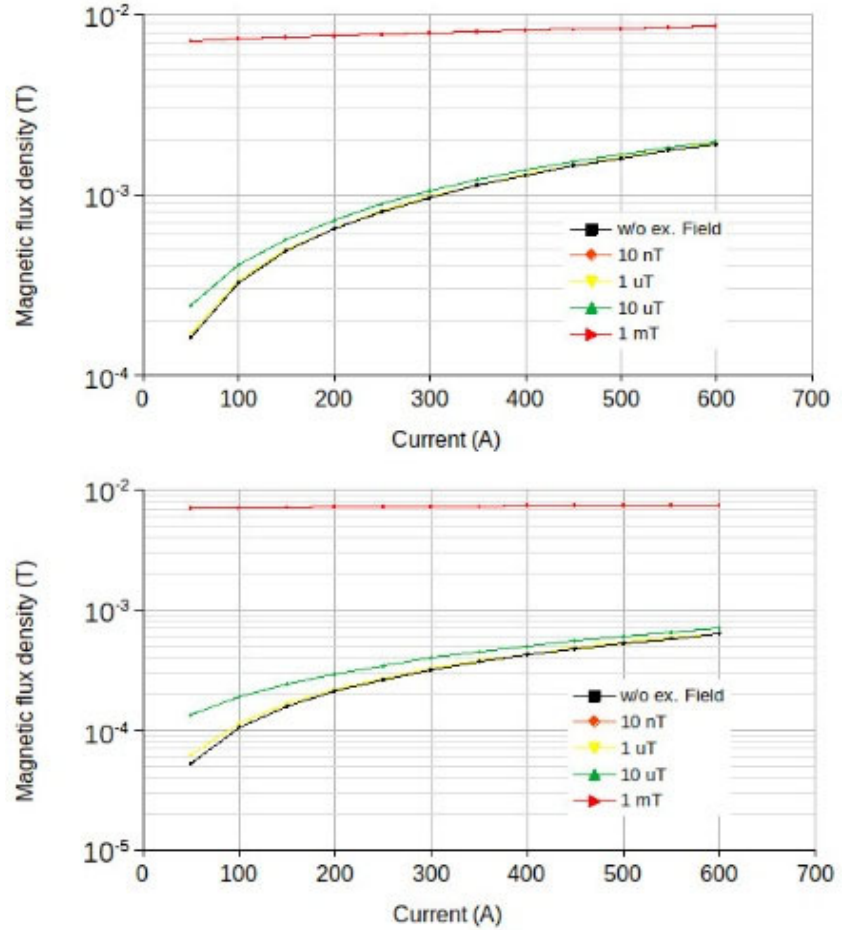
Figure 4. The dependence of the values of the Y-component of the magnetic field vector in the core of the ferroprobe on the current value in the cable for various values of the external magnetic field induction. Upper panel—distance 1 m between the microtunneling shield and the cable, lower panel—distance 3 m.